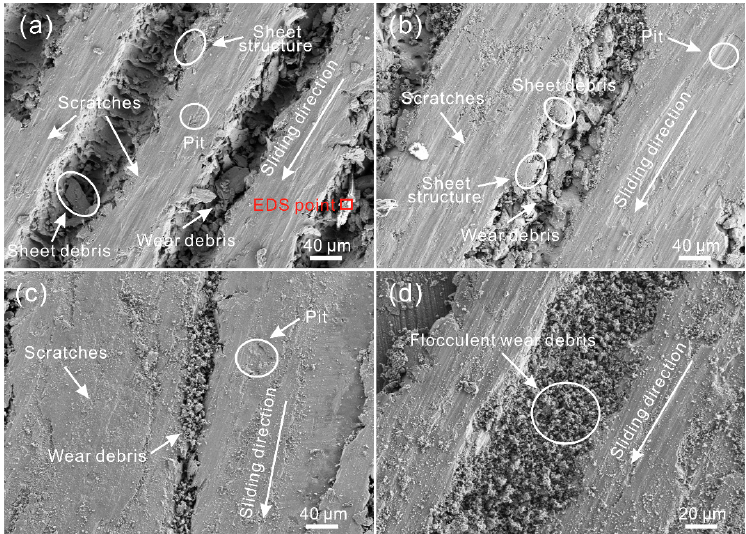
Figure 15. SEM images of the worn surface of the AGS with a texture spacing of ( a ) 150 µ m, ( b ) 250 µ m (load of 0.3 N, sliding speed of 100 mm/s, frictional pair of GCr15 bearing steel); ( c ) SEM image of the worn surface of the arc groove surface with a texture spacing of 250 µ m (sliding speed of 400 mm/s); ( d ) SEM image of black wear debris on the worn surface of the AGS with a texture spacing of 350 µ m (sliding speed of 400